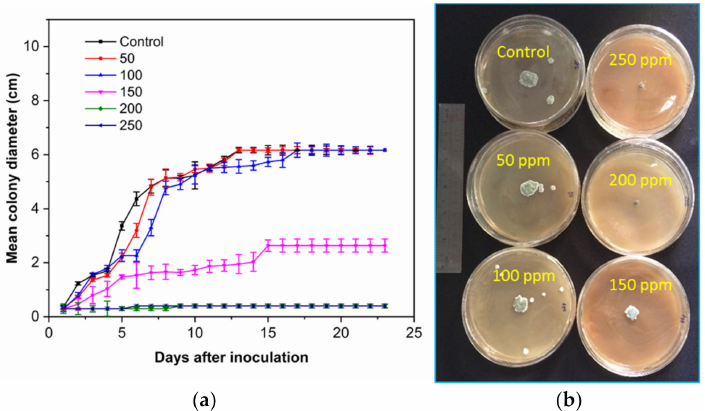
Figure 6. ( a ) The antifungal activity of SCNs at different concentrations against A. alternate incubated at 28 ◦ C for 22 days and ( b ) plates incubated for 16 days.